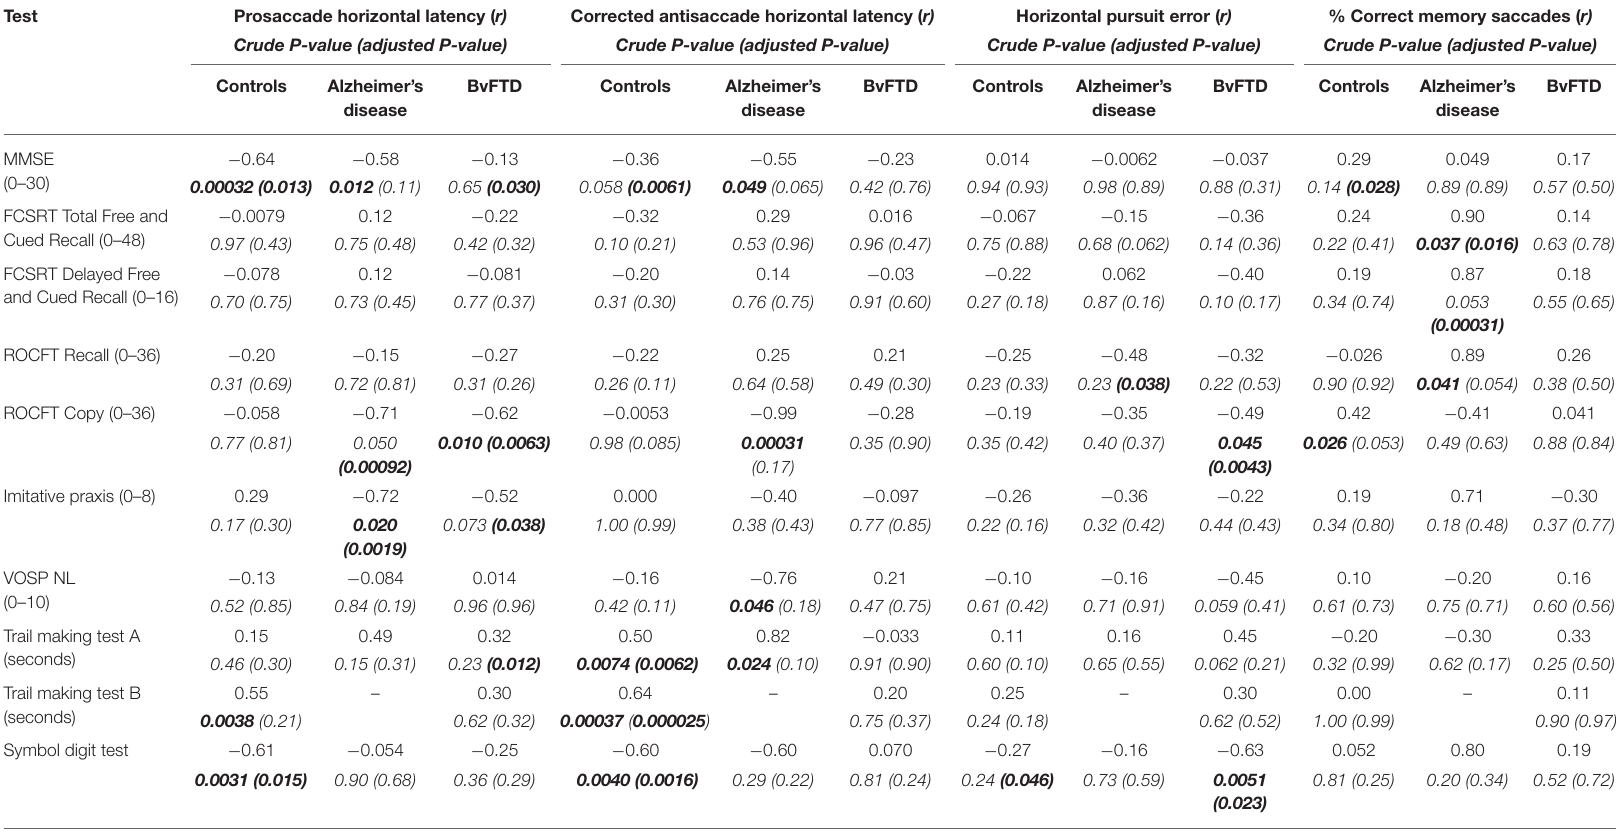
TABLE 5 | Relationship between neuropsychological performance and oculomotor